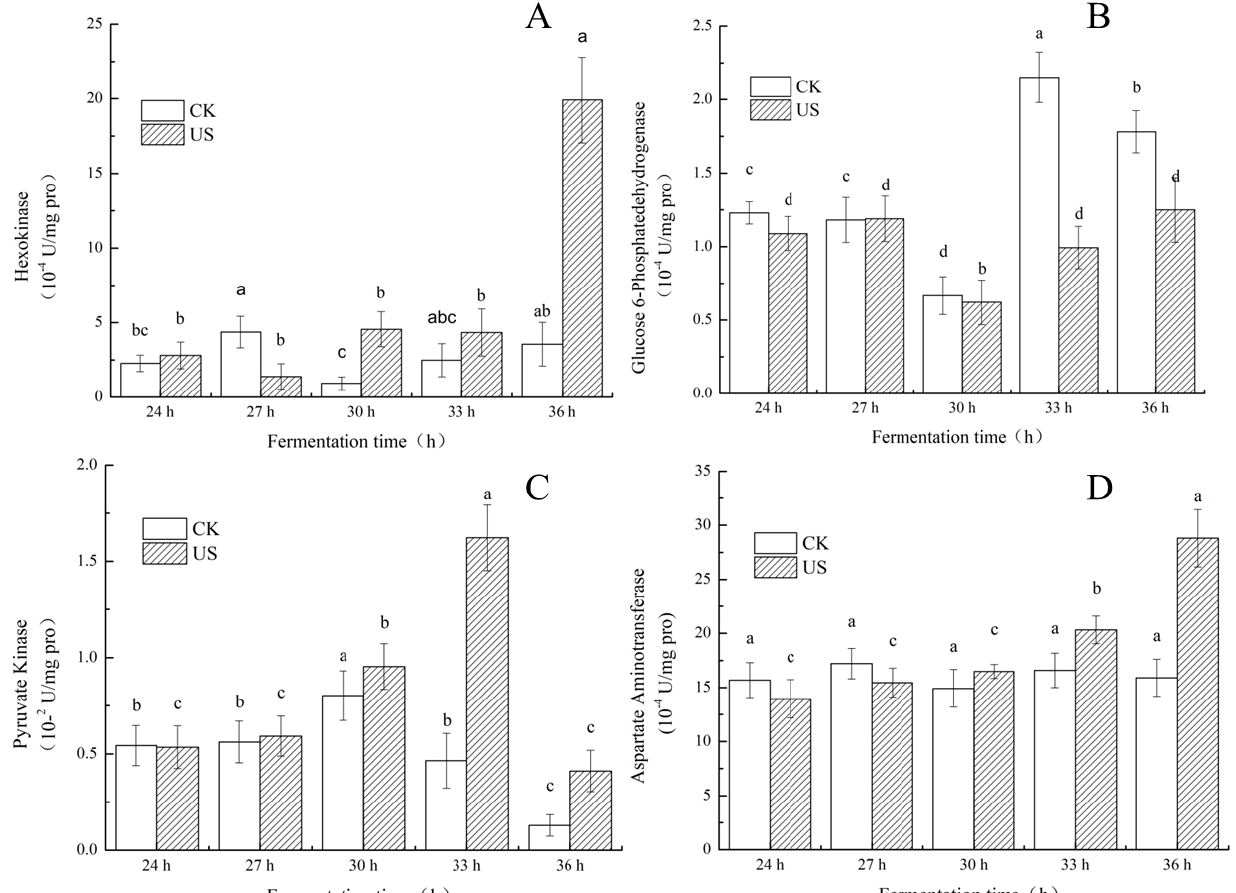
Figure 6. Changes of enzymatic activity of the key enzyme of ultrasound-assisted fermentation in a 3-L-jar fermenter by SAR 14-116 (( A ) HK; ( B ) G6PDH; ( C ) PK; ( D ) AAT). (Lowercase letters a, b, c and d indicate that there is a significant difference between the different culture time of fermentation ( p < 0.05)).